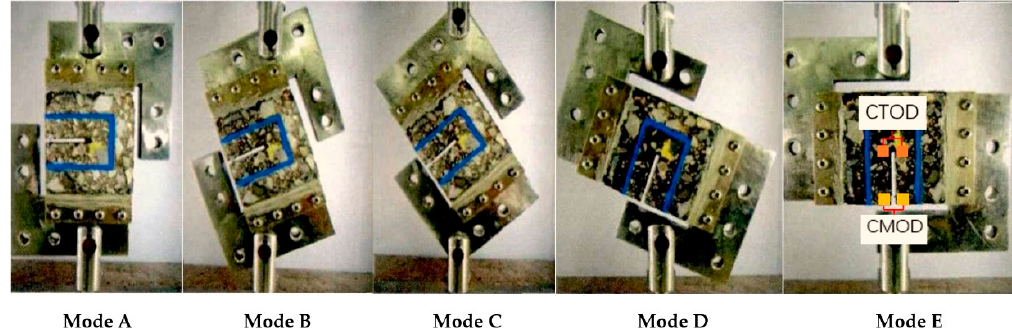
Figure 1. Arcan test configuration with five levels of mixed-mode cracking.